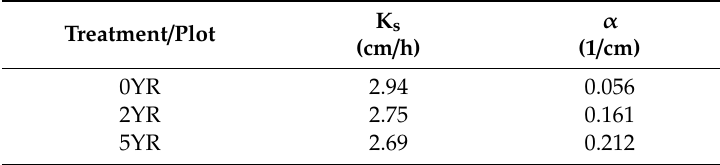
Table 2. Saturated hydraulic conductivity, K s , and sorptive number, α , estimated through the procedure described in Section 2.2 and averaged on five replicates of the infiltration tests performed on each plot